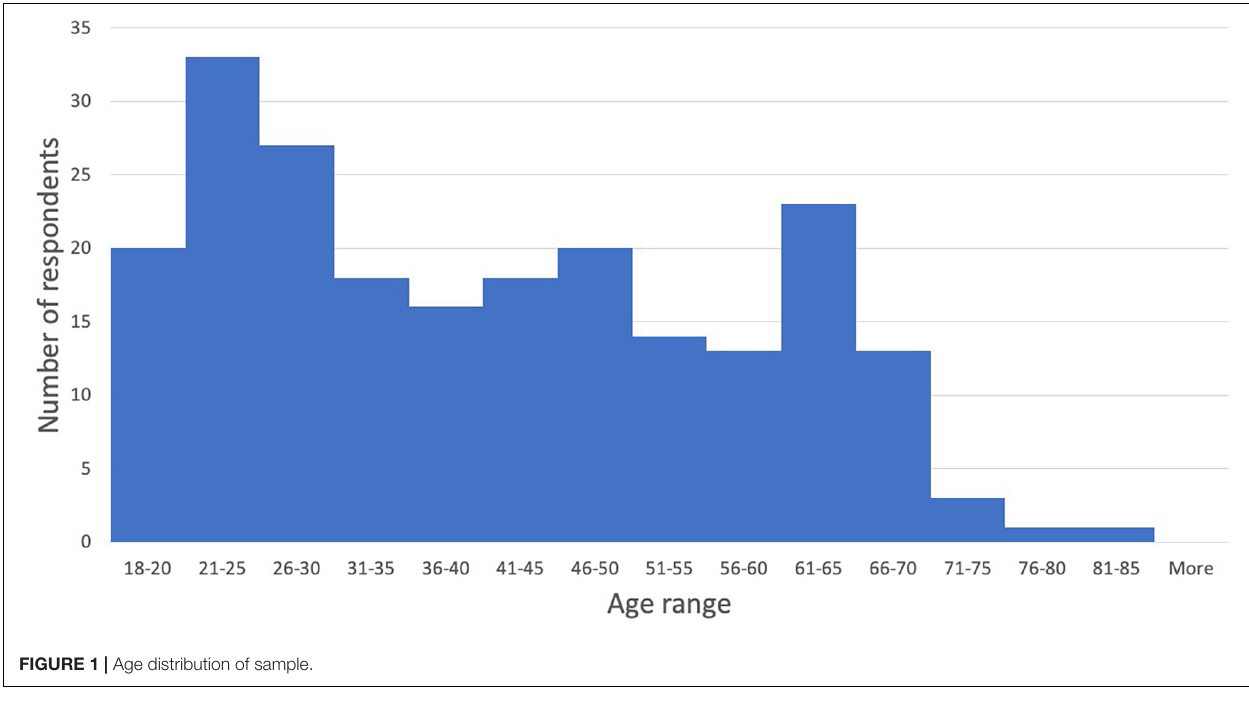
FIGURE 1 | Age distribution of sample.